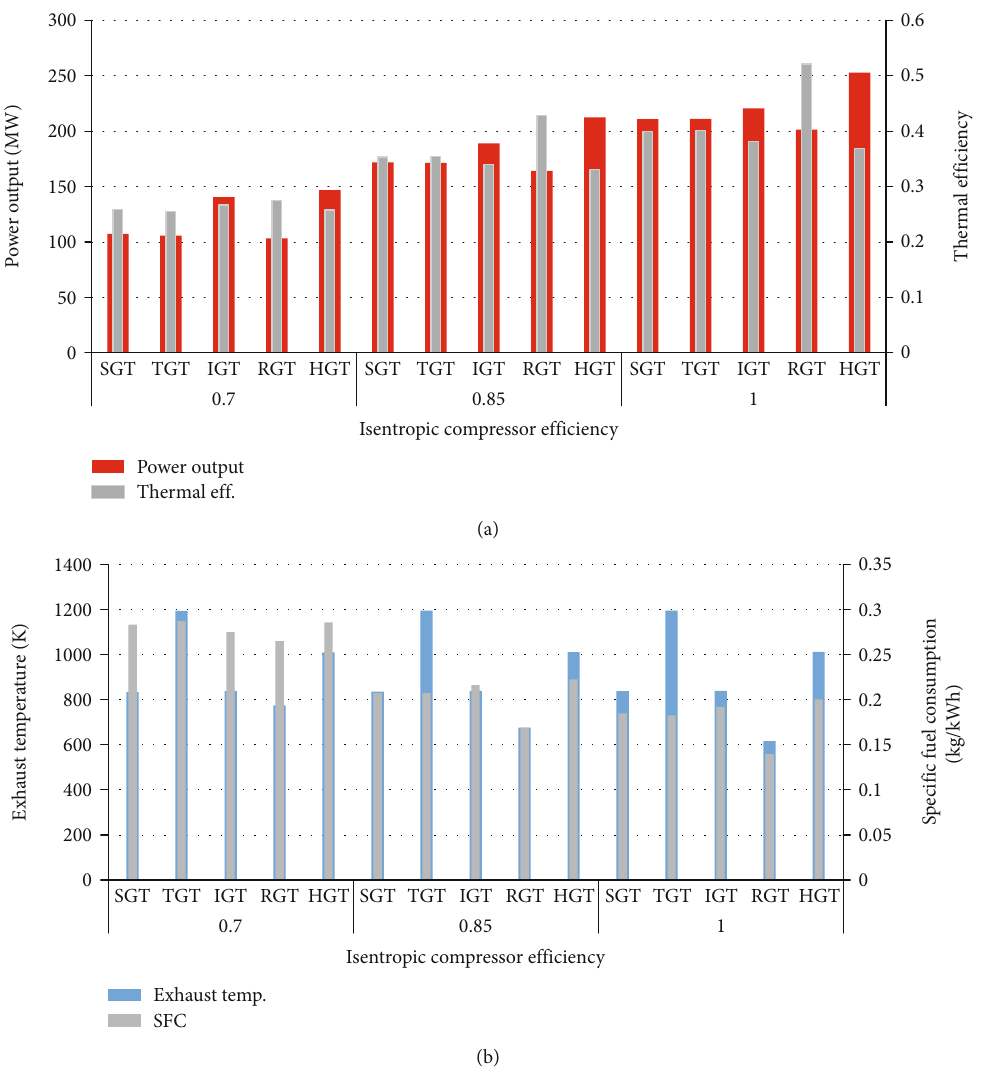
Figure 10: The impact of the isentropic compressor e ffi ciency ( C